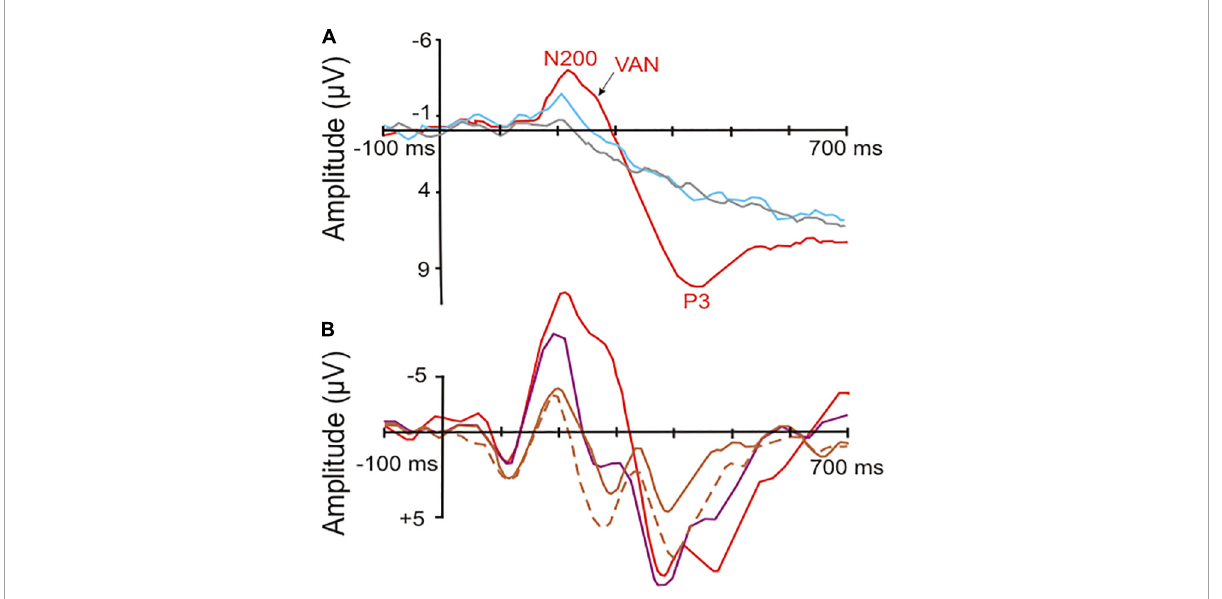
FIGURE1 Event-related potentials (ERPs) in response to visual stimuli (starting at the point of origin) in human observers. (A) Potentials recorded from surface electrodes above the occipital cortex contralateral to the stimulated visual field. Red curve, correct response with high-awareness; blue curve, correct response reported without awareness; gray curve, incorrect response without awareness. The red and blue curves show significant visual awareness with peaks near 200 ms latency (N200, visual awareness negativity, VAN) after stimulus onset. In addition, the red curve shows a so called P3 (positive peak later than 300 ms after stimulus onset), which is related to a conscious response [modified from Koivisto and Grassini (2016); part of their Figure 2]. (B) Potentials recorded from surface electrodes above the left-side posterior-temporal cortex to stimuli in the center of the visual field. Red curve, high-awareness with behavioral response to relevant stimulus; purple curve, low-awareness without response to irrelevant stimulus; brown curves, looking at masked relevant (solid line) or masked irrelevant stimulus (dashed line) without response requirement. The visual awareness negativities (peaks near 200 ms latency after stimulus onset) increase with increasing visibility and relevance of the stimuli corresponding to a respective increase in the awareness of the stimuli. Only the red curve shows a broad P3-like peak in the latency range of about 350–500 ms, possibly related to the required (conscious) behavioral response [modified from Koivisto and Revonsuo (2008); their Figure 7 at T5 of the left